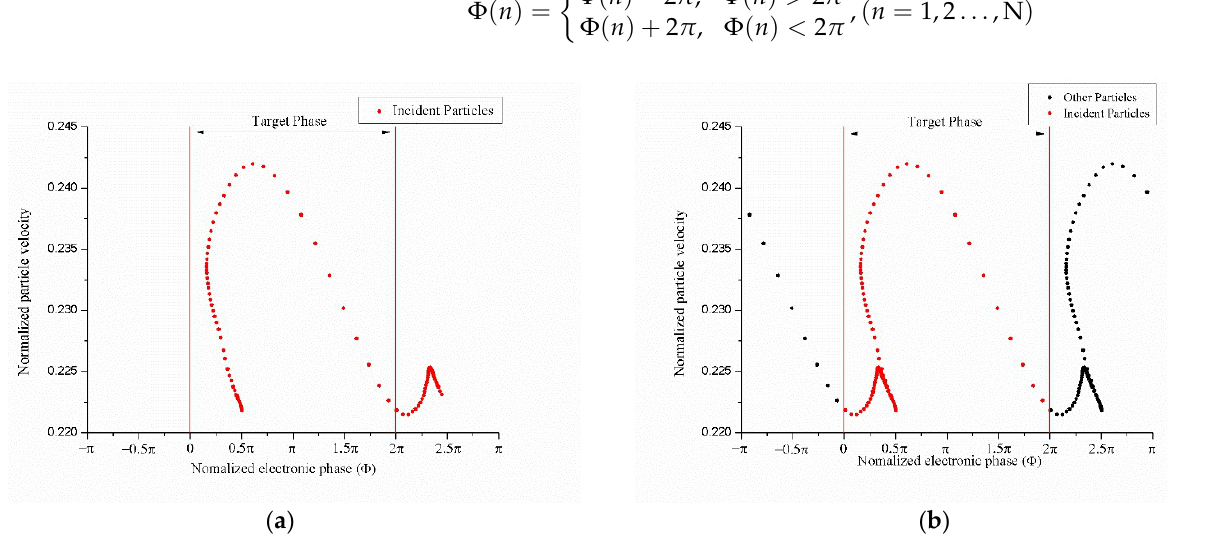
Figure 3. ( a ) The phase distribution of particles during interaction. ( b ) The particles at ( 0,2 π ) chosen from periodic extended particles.